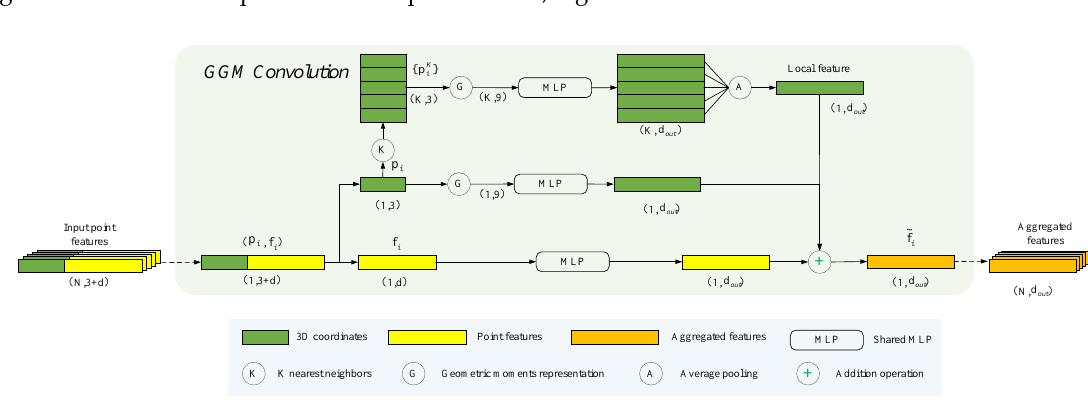
Figure 6. Architecture of the graph geometric moments (GGM) convolution.